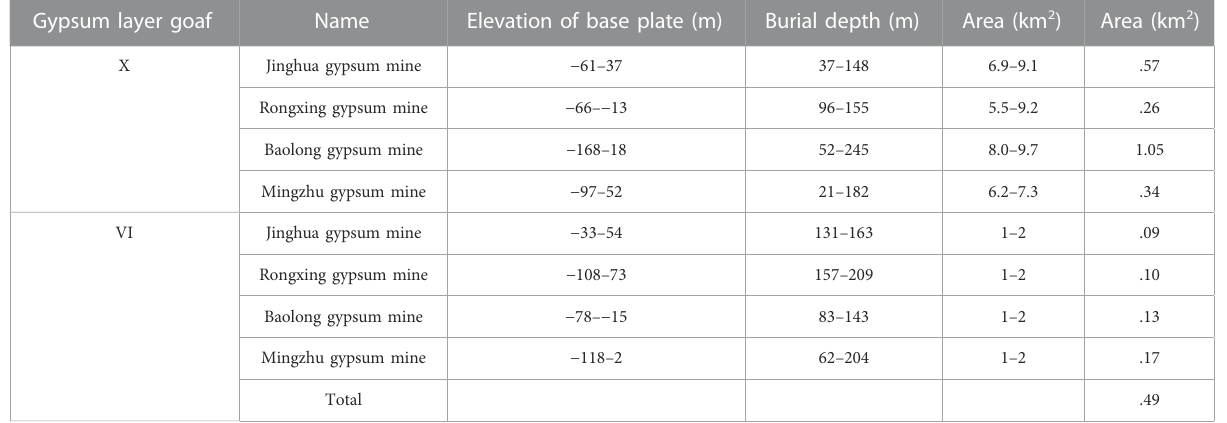
TABLE 2 Statistical table of the distribution of goafs in X and Ⅵ gypsum layer in each mining area. Gypsum layer